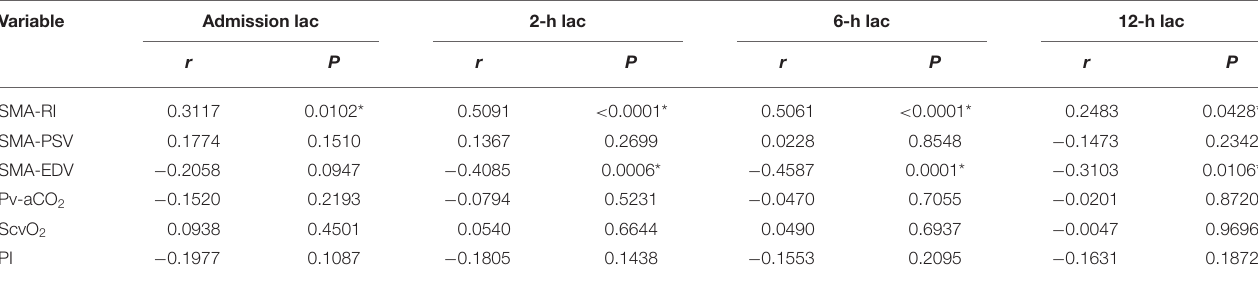
TABLE 2 | Correlation analysis of lactate concentrations, superior mesenteric artery flow, and hemodynamic parameters.